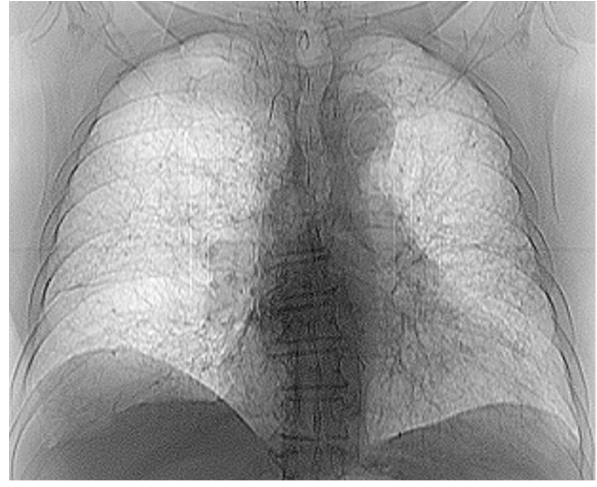
Figure 2. The selection of the portion of interest of the lungs of patient MT.